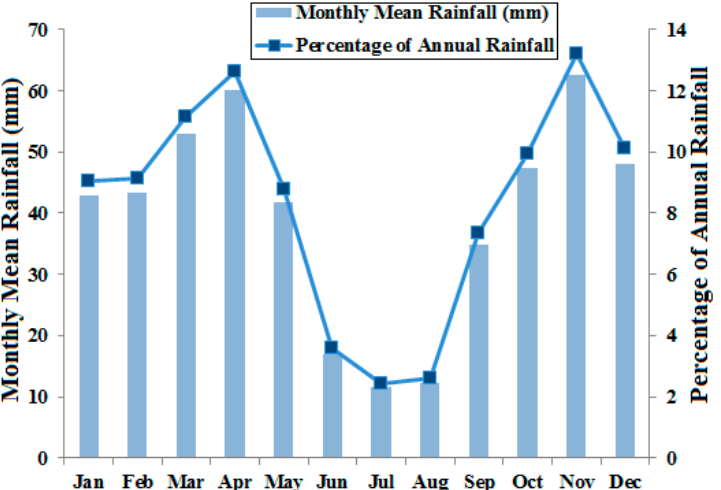
Figure 2. Monthly distribution of rainfall computed over the period 1991–2015.